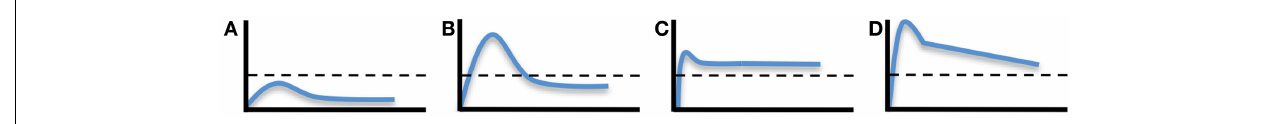
vaccines require booster vaccination. Long-lived protective immunity may be achieved by durable or nearly steady-state levels of immunity (C) or through the development of strong but rapidly declining immunity (D) , if the starting point begins high in reference to the protective threshold. It is important to note that the protective threshold will differ by pathogen or disease and an immunological correlate of protection must be known in order to extrapolate the potential durability of a particular vaccine-mediated immune